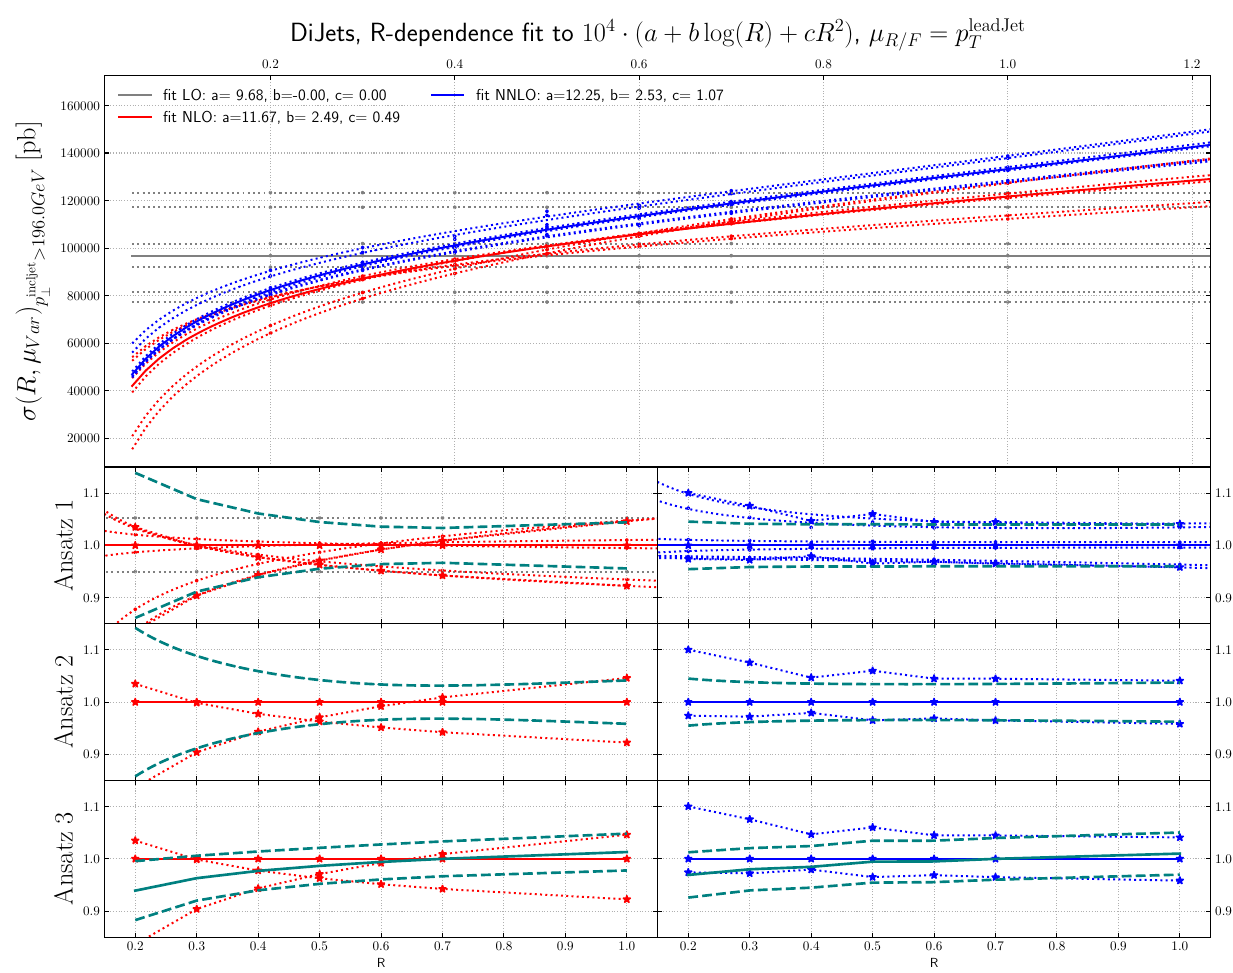
Fig. 11 The R -dependence of the cross sections for inclusive jet production at LO, NLO, NNLO and NLO+PS are shown, for scale variations around a central scale of μ R / F = p lead jet , as a function of jet radius, for dijet production, for leading jet transverse momenta above 196 T